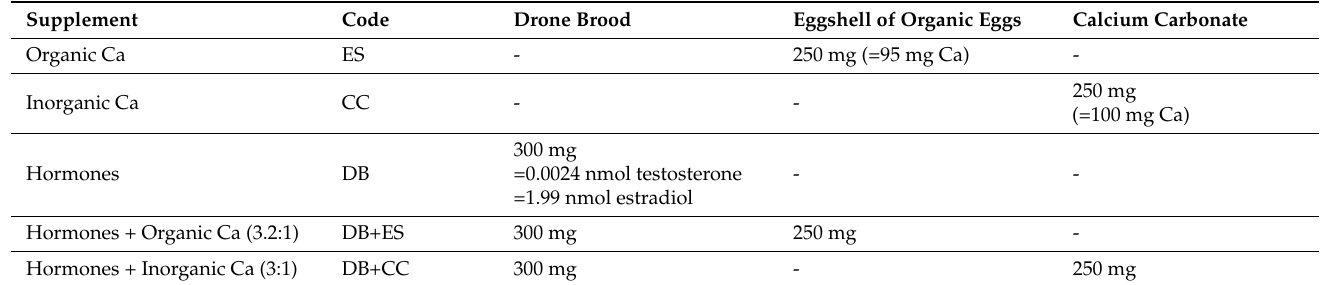
Table 1. The composition of prepared dietary